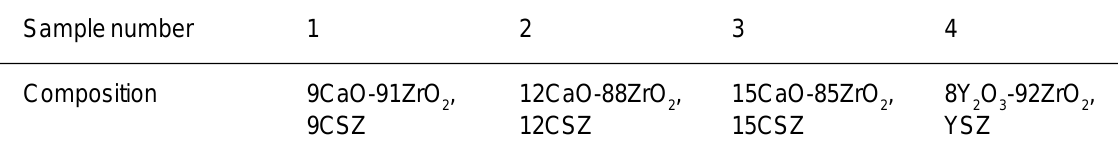
Table 1. Numeration of zirconia solid